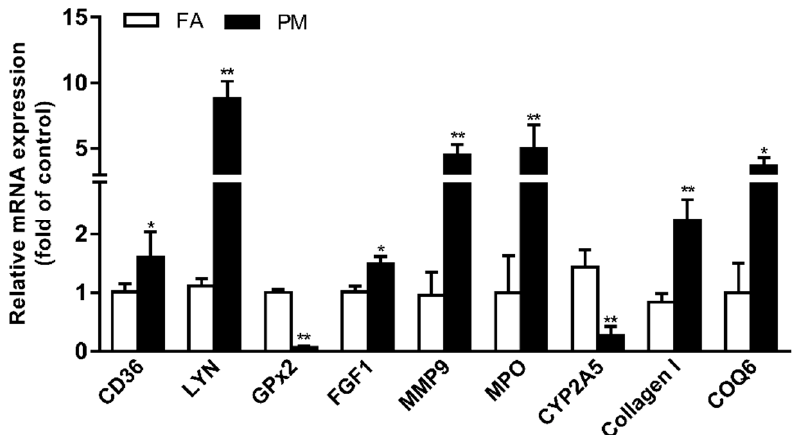
Figure 5. Real-time polymerase chain reaction analysis confirming the gene expression profiles obtained from proteomic data in the lungs of PM 2.5 -exposed mice. Data are presented as the mean ± SD of three independent experiments. * p < 0.05; ** p < 0.01—vs. the FA group. FA: filtered air, PM: particulate matter.